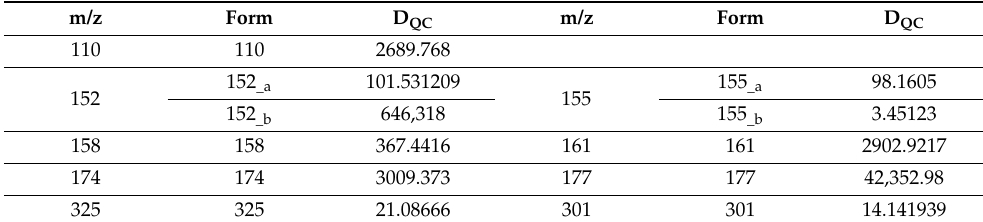
Table 1. Theoretical D QC parameters of Equation (3) according to most stable analyte 3D molecu- lar and electronic structures of species at ground and transition states and energetics (Table S15); frequencies and atomic coordinates are listed in Tables S16 and S17.